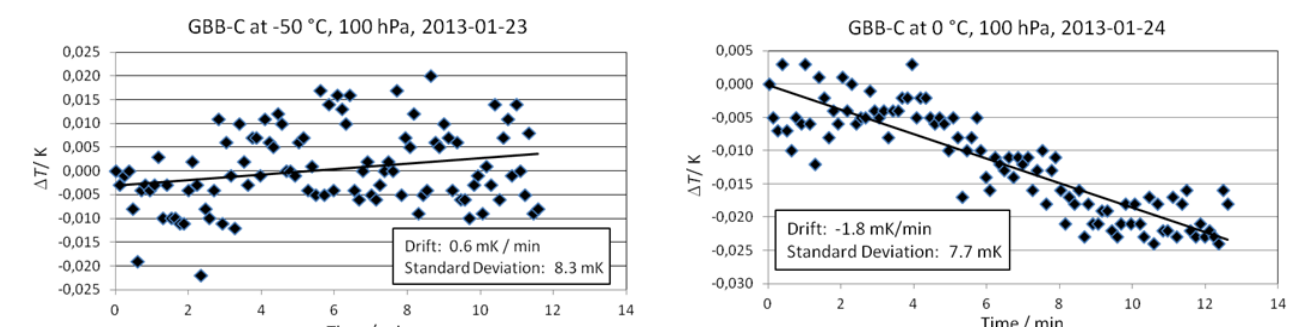
Fig. 15. The spatial distribution of the radiation temperature of the GLORIA blackbody GBB-C at a nominal temperature of − 50 ◦ C and 100hPa. The field-of-view is 82mm × 82mm. The measured data is shown on the left panel, the spline interpolated data on the right. The homogeneity is 132mK (standard deviation).